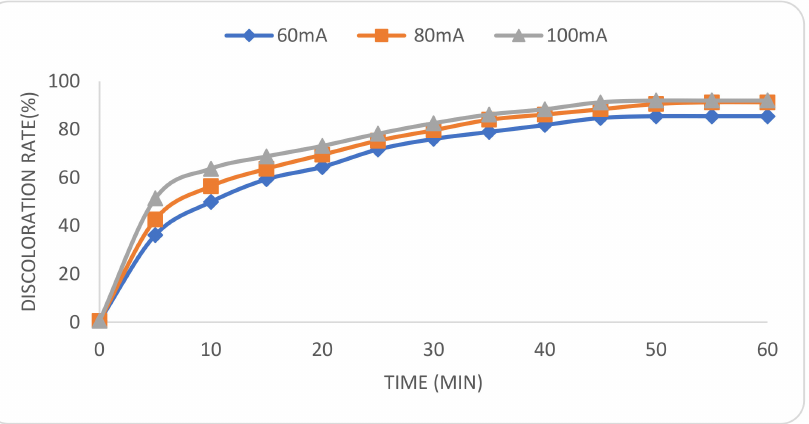
Figure 3. Effect of current intensity on discoloration rate [MO] = 20 mg/L, 50 mM Na 2 SO 4 , I C = 100 mA, PH = 3, 0.2 mM Fe 2+ ; 8.8 mM H 2 O 2 , and T = 30 ± 0.1 ◦ C.